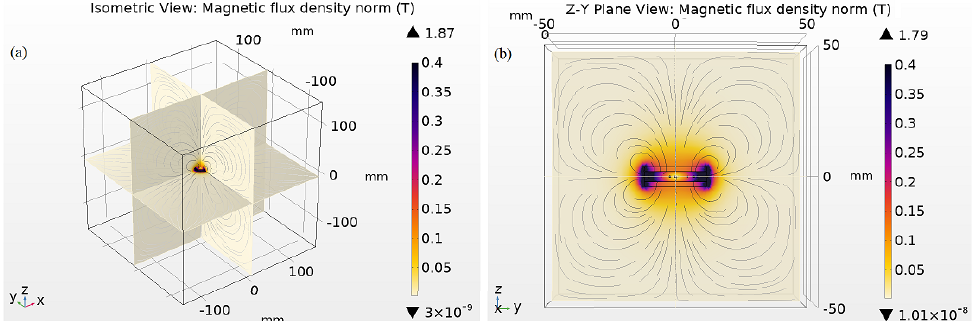
Figure 9. COMSOL-generated field based on two N52 axially magnetized disk magnets with a diameter of 25.4 mm and a thickness of 3.175 that are attached for a total thickness of 6.35 mm and a B r max of 1.48 T along the z -axis, as referenced in Figures 5 and 8. ( a ) Isometric view with the original boundary conditions of − 150 mm to 150 mm used for the data simulation process and theoretical predictions. ( b ) Emphasis of the field at close proximity to the magnet surface along the ZY